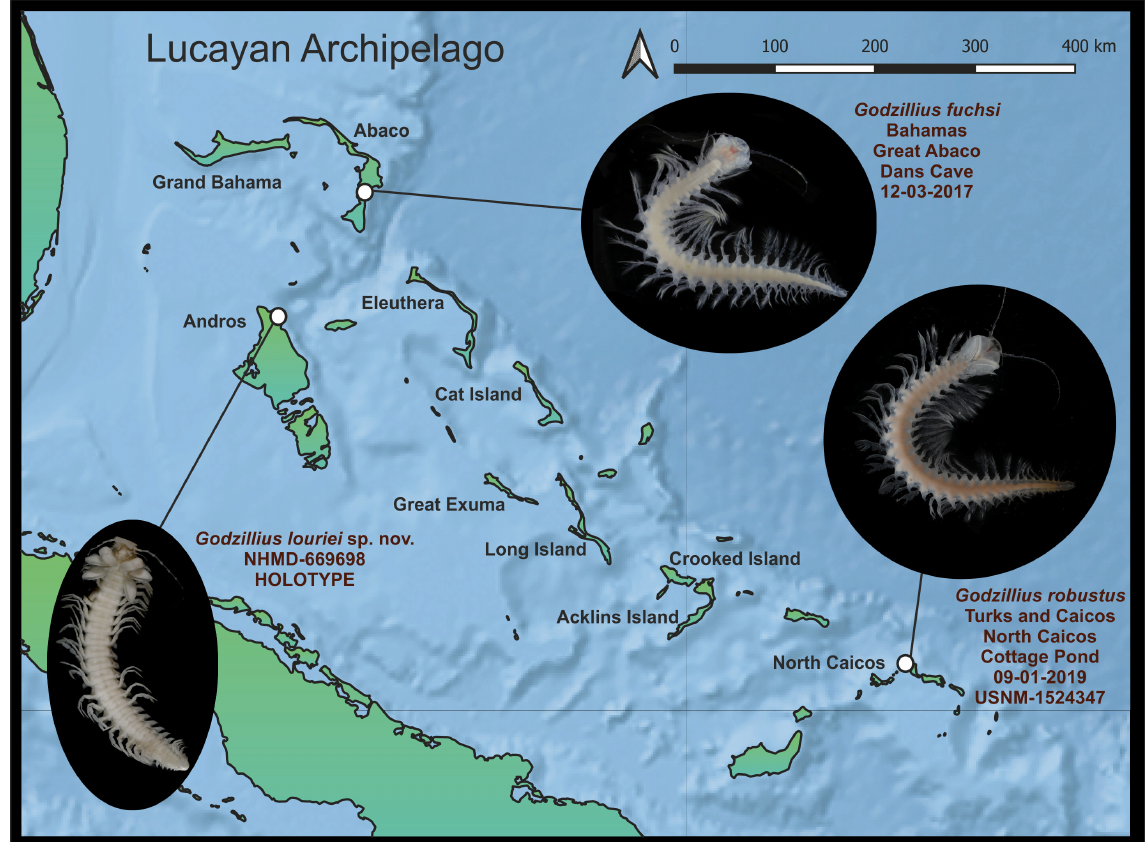
Fig. 1. Distribution of the genus Godzillius Schram, Yager & Emerson, 1986 within the Lucayan Archipelago. Type localities of Godzillius fuchsi Gonzalez, Singpiel & Schlagner, 2013, G. louriei sp. nov. and G. robustus Schram, Yager & Emerson, 1986 are indicated. Map constructed using the open source QGIS ver. 3.12 software (QGIS Development Team 2020) and metadata from Natural Earth